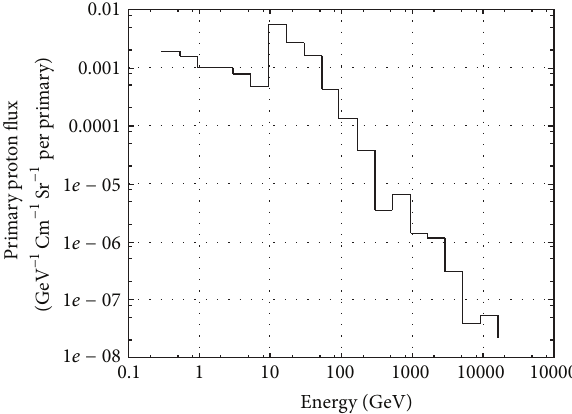
Figure 2: The differential primary proton fluence